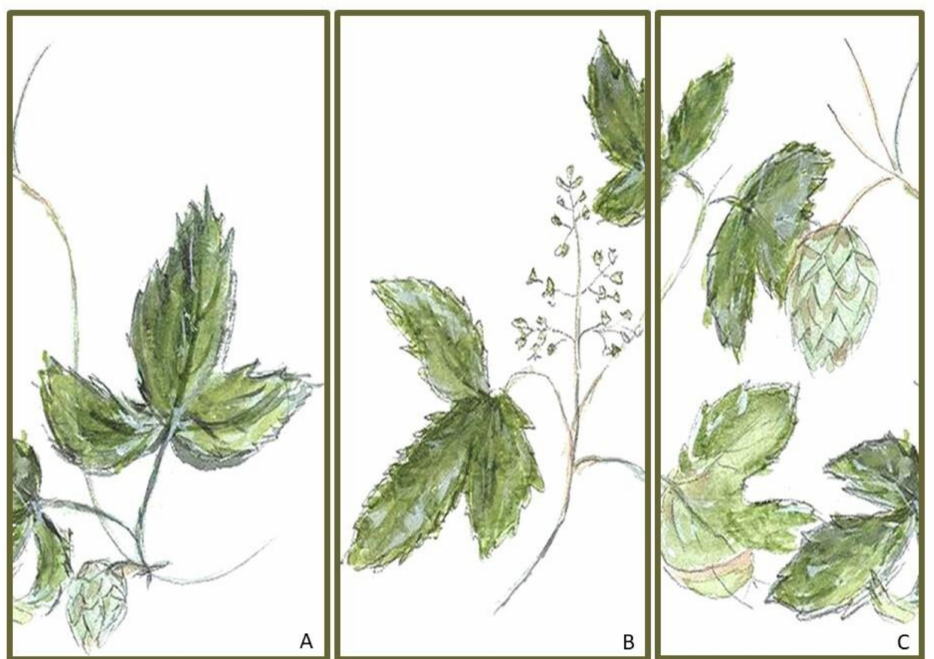
Figure 1. ( A ) H. lupulus leaves are deeply 3- to 5-lobed and coarsely dentate; ( B ) male flowers; ( C ) female